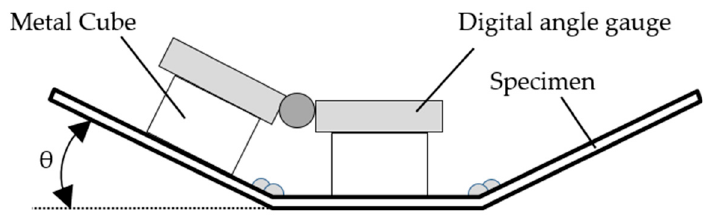
Figure 4. Schematic of angular distortion measurement.